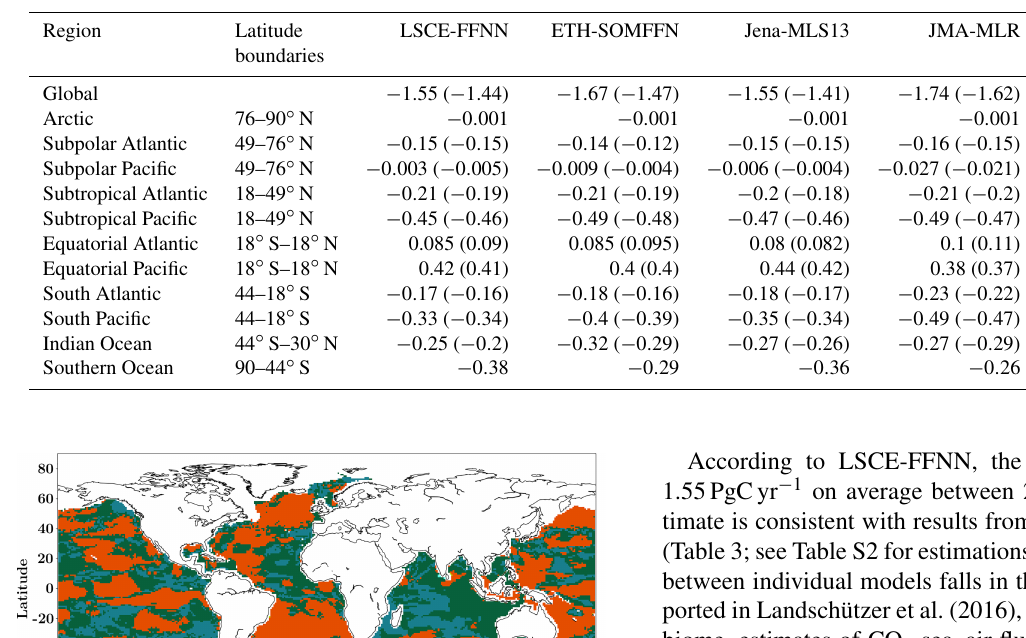
Table 3. Mean of sea–air CO 2 flux (PgCyr − 1 ) over the global ocean and per region for the common period (2001–2015). Averages over the period from 2001 to 2009 are presented in parentheses. The last column presents a comparison with the best estimates from Schuster et al. (2013) for the Atlantic Ocean (1990–2009).